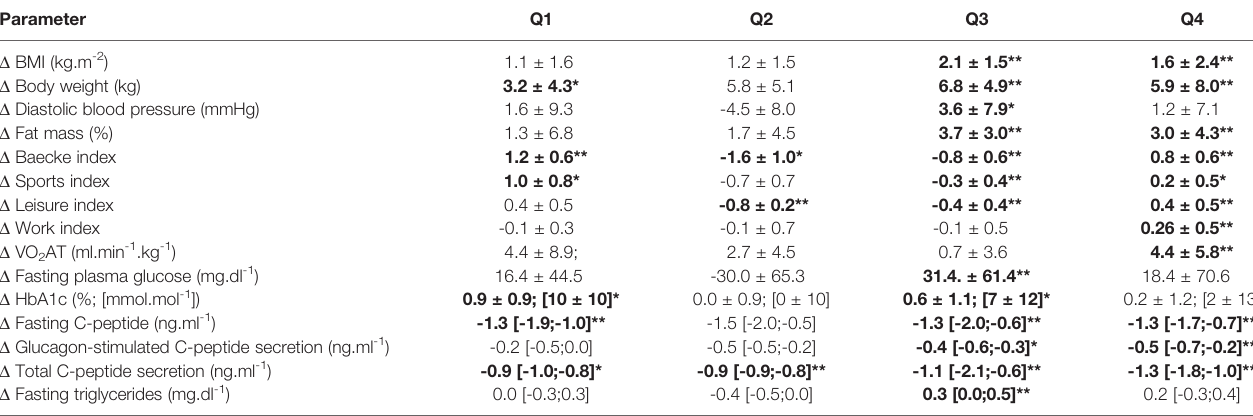
TABLE 3 | Subgroup analysis of changes ( D ) of anthropometric, performance and metabolic parameters based on response to changes in whole-body insulin sensitivity and PA participation over 5 years for patients with type 1 diabetes, divided into Q1 (n=9), Q2 (n=5), Q3 (n=33) and Q4 (n=34). Parameter Q1